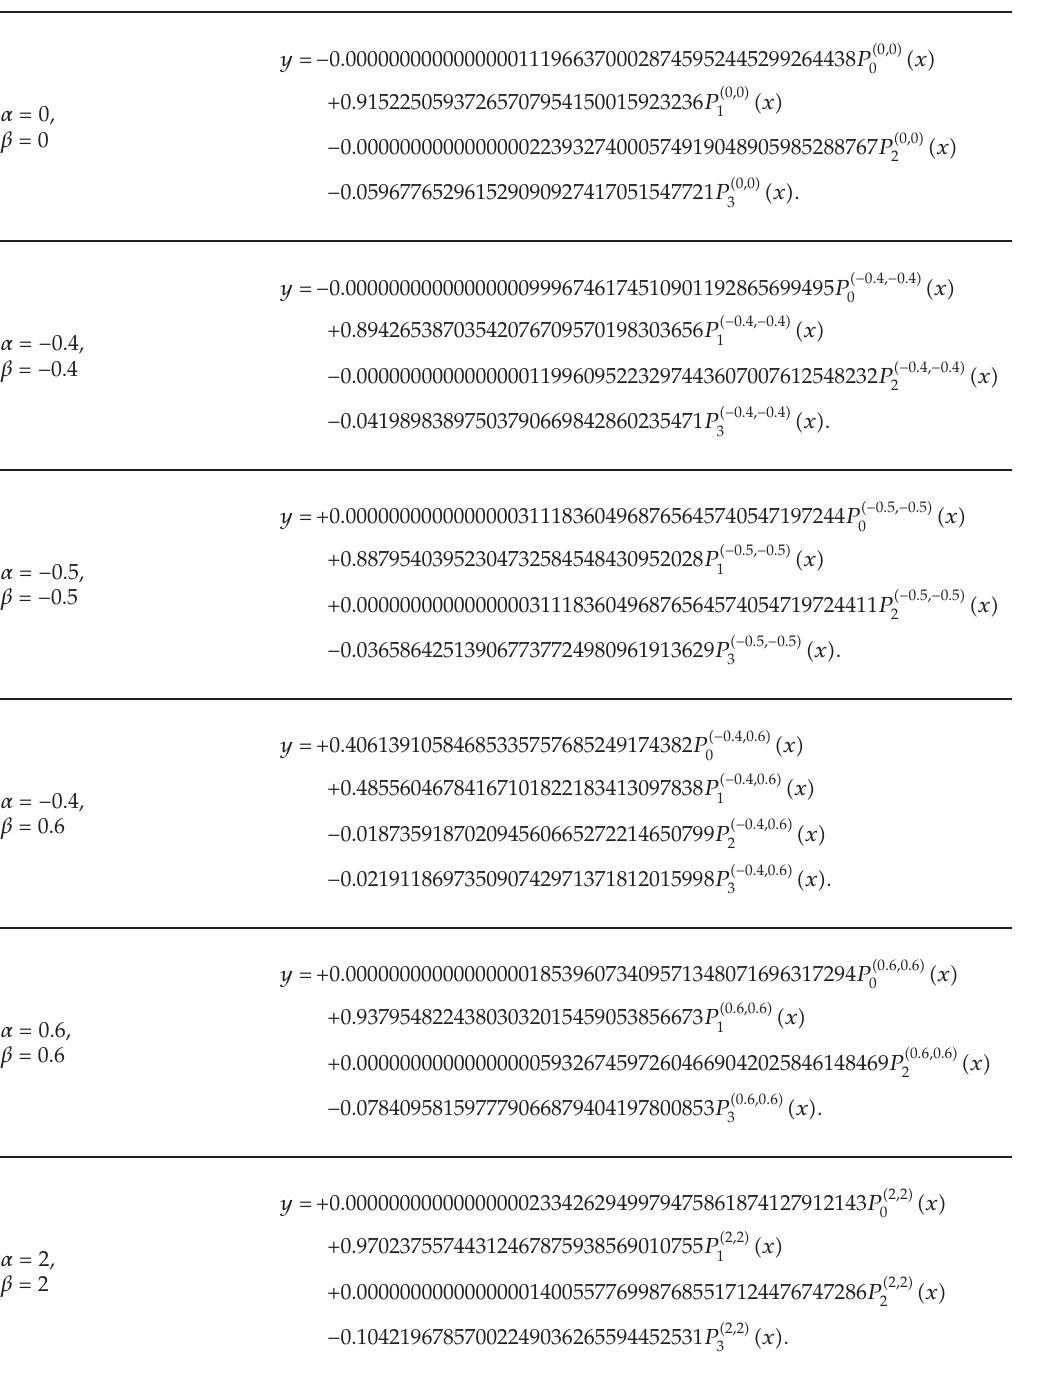
Table 2: The solution of our example for di ff erent values of α and β